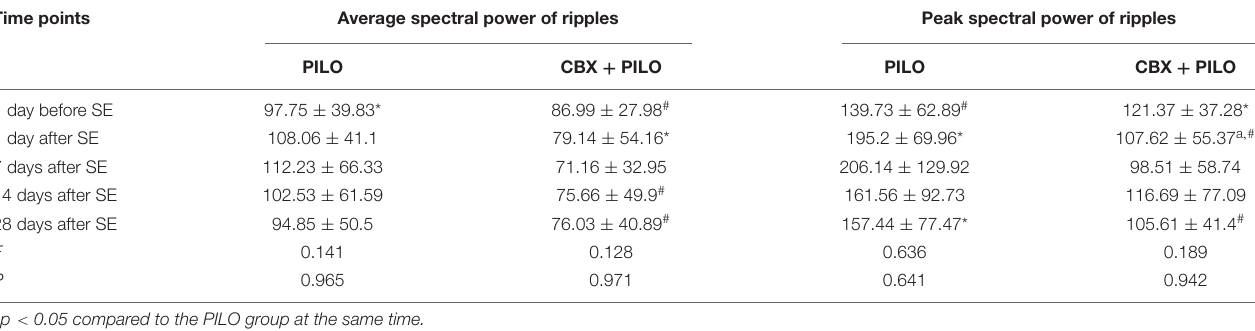
TABLE 1 | Dynamic changes in the average and peak spectral power of ripples recorded in RLs in the PILO and CBX + PILO groups at different time points after SE ( n = 8). Time points Average spectral power of ripples Peak spectral power of ripples